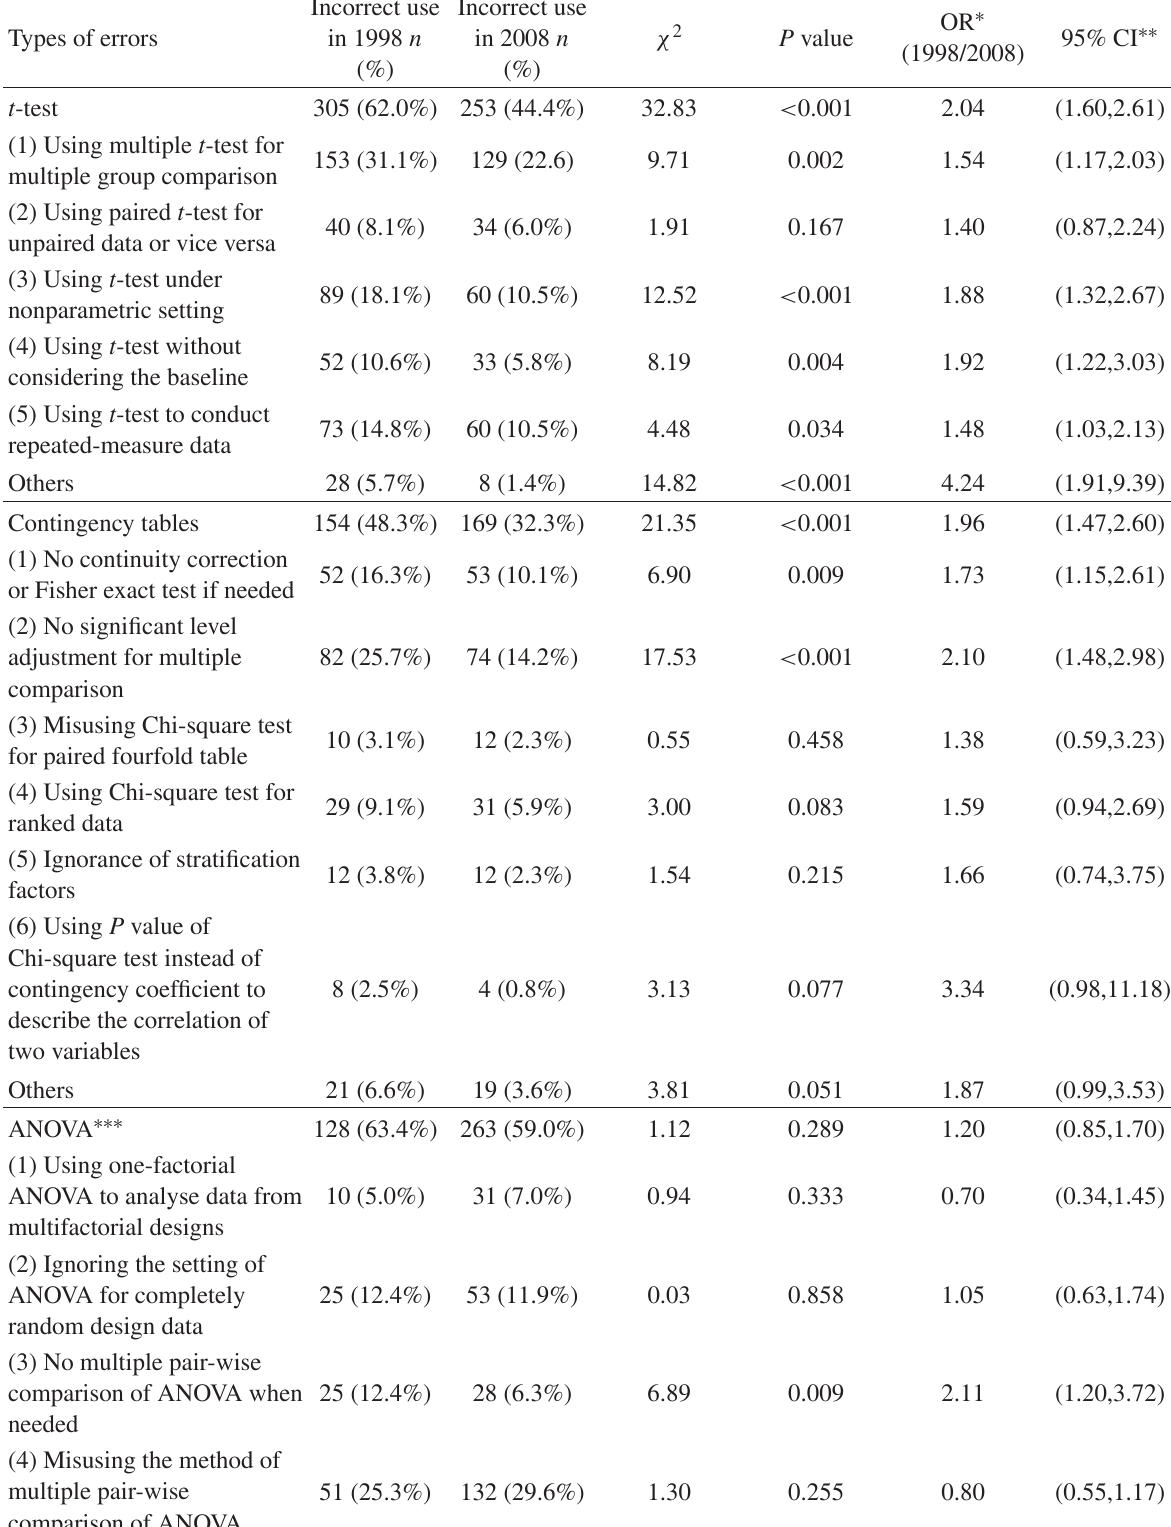
TABLE 1: Errors/defects in statistical